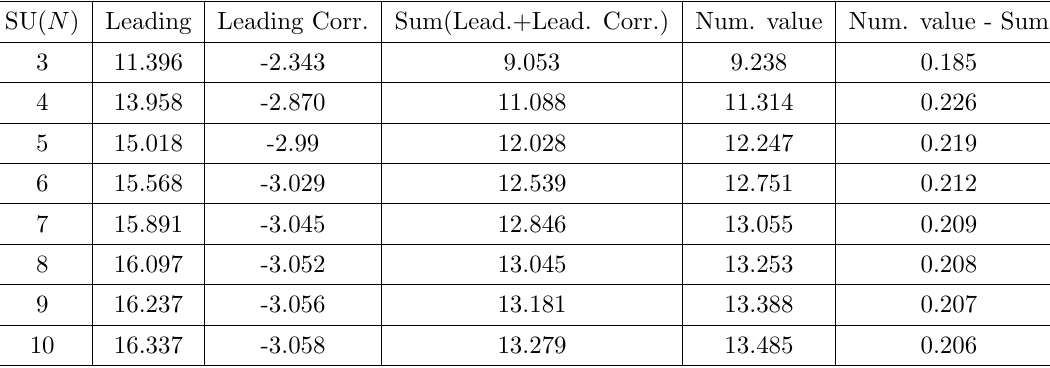
Table 9 . Comparison of N -ality 2 k -strings for SU(3